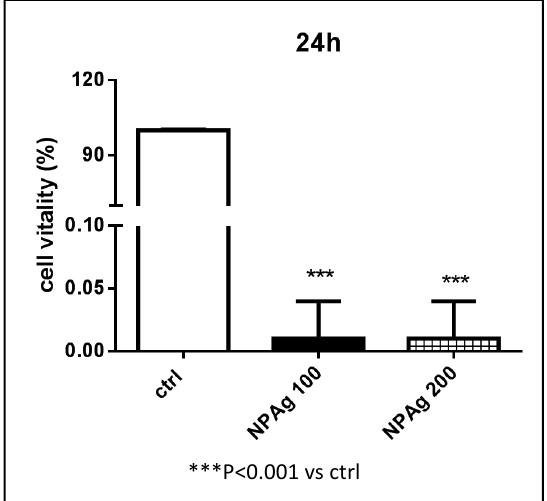
Figure 4. Cell viability % of hepatocellular carcinoma (HepG2) cells NOT TREATED (ctrl), TREATED with AgNP suspension at 100 (NPAg 100) and 200 (NPAg 200) ppm.